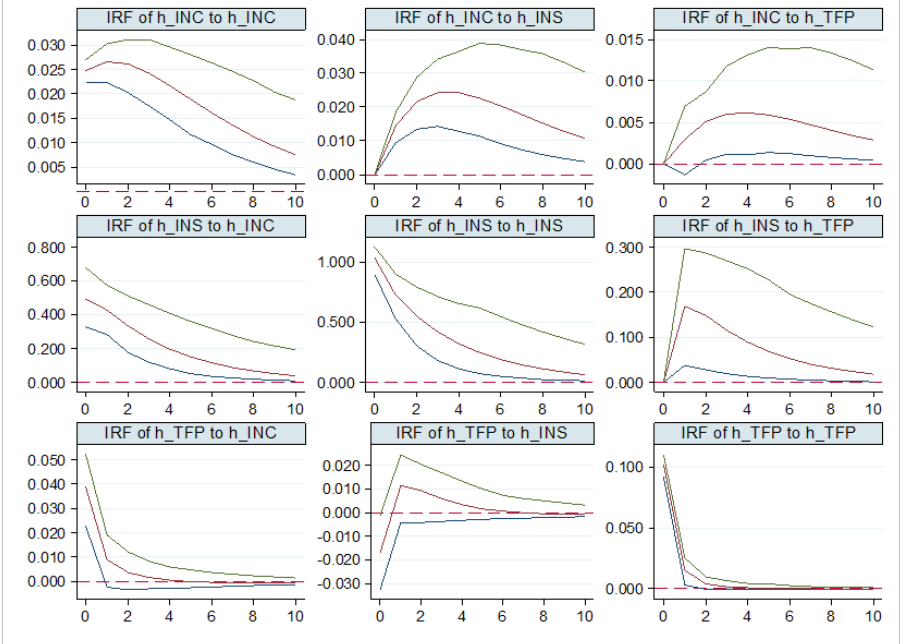
Figure 1. Impulse response diagram in high density areas.